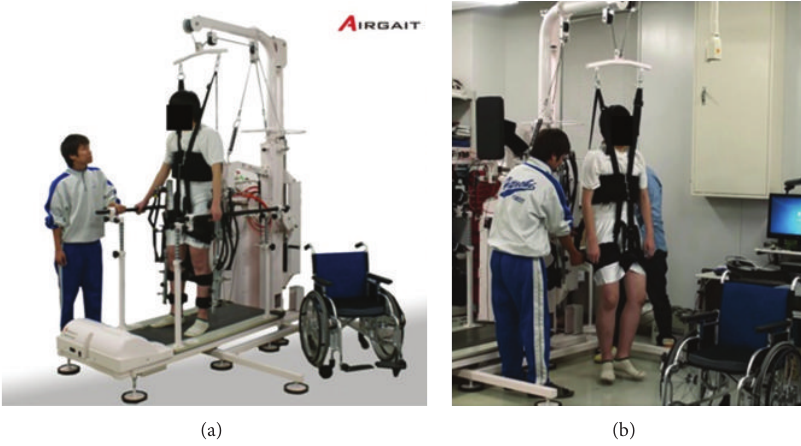
Figure 3: Body weight support gait training system (AIRGAIT)